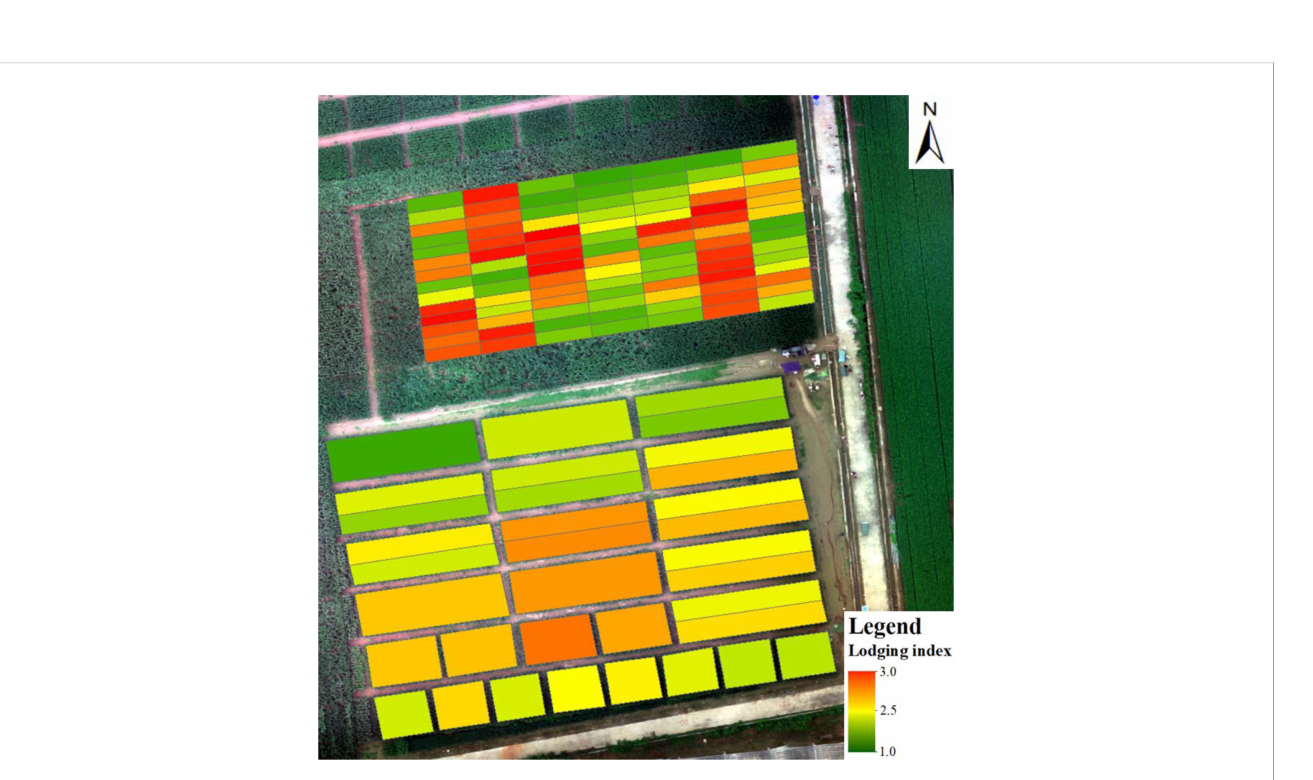
FIGURE 7 Distribution of lodging index for each plot.